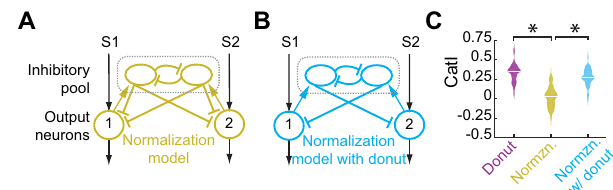
Fig. 6 Divisive normalization model is not effective at producing categorical response pro fi les. A Schematic of normalization circuit model with pooled inhibition and inhibitory feedback 55,56 . B Schematic of normalization circuit with self-inhibition removed (i.e., with donut-like inhibition introduced). C Plot of CatI computed from the responses of neuron 1 in the normalization model ( A ; gold data) and in the model lacking self-inhibition ( B ; blue data), to the standard two-stimulus morphing protocol (as in Fig. 2C); n = 50 model neurons; center lines in the violin plots indicate median values. For comparison, the CatI values for the model from Fig. 2D that contains the donut-like motif (purple), is reproduced here; p = 5.2e-23 (gold vs. purple), p = 8.8e-19 (gold vs. blue), paired two-sided t tests with HBMC correction. Source data are provided as a Source Data fi